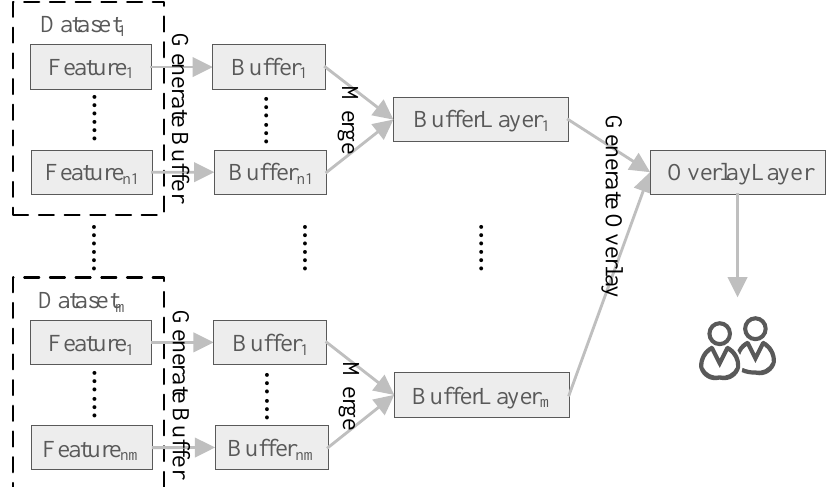
Figure 2. Buffer-overlay analysis flow using traditional methods.